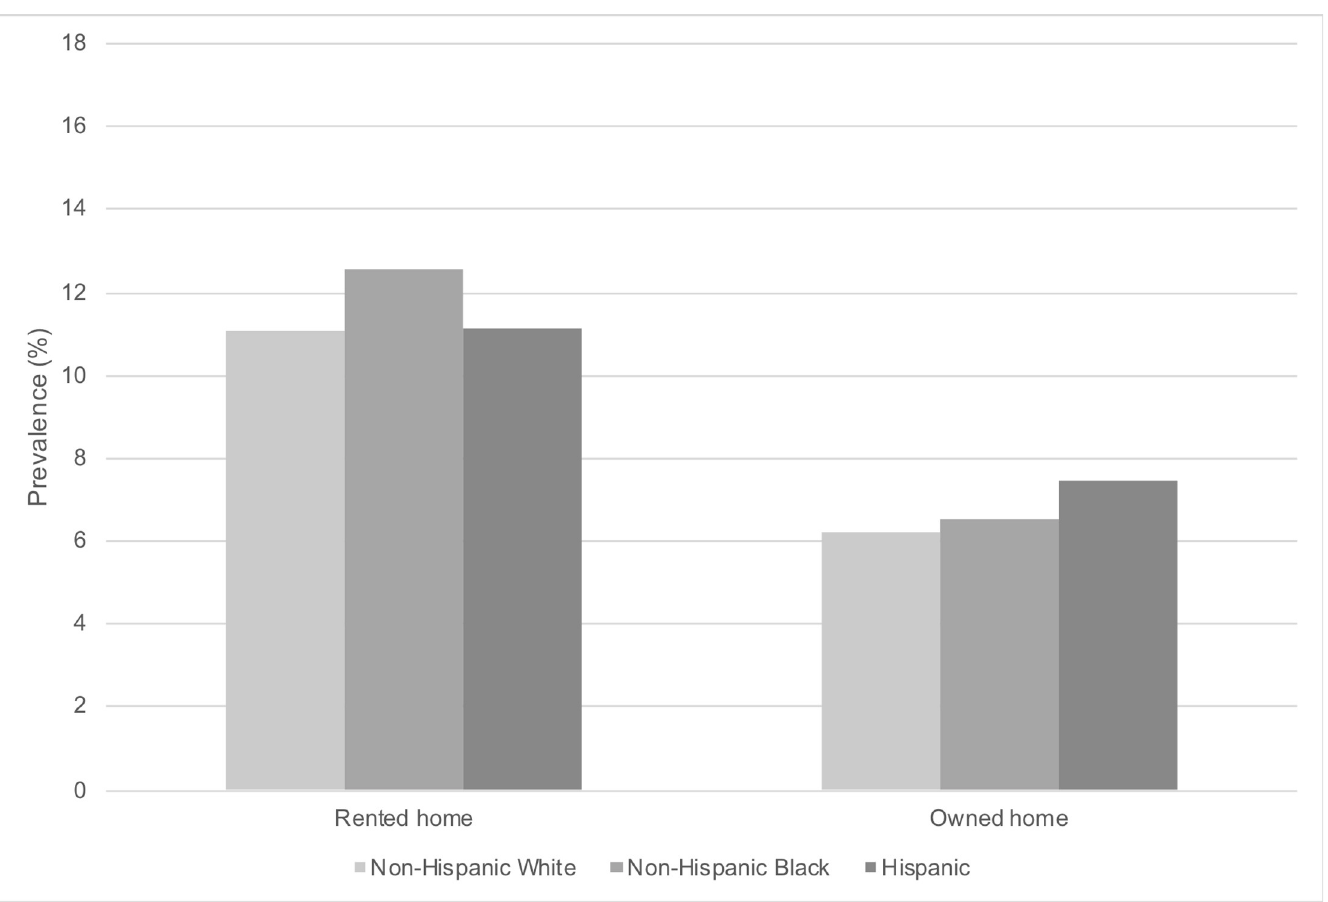
Fig 4. Weighted prevalence of probable depression by race/ethnicity and home ownership in U.S. adults (N = 26,382). The National Health and Nutrition Examination Survey (NHANES) 2007–2016. Missing values for home ownership (n = 295). Weighted to the U.S. population. Probable depression defined by Patient Health Questionnaire-9 (PHQ-9) cutoff of �